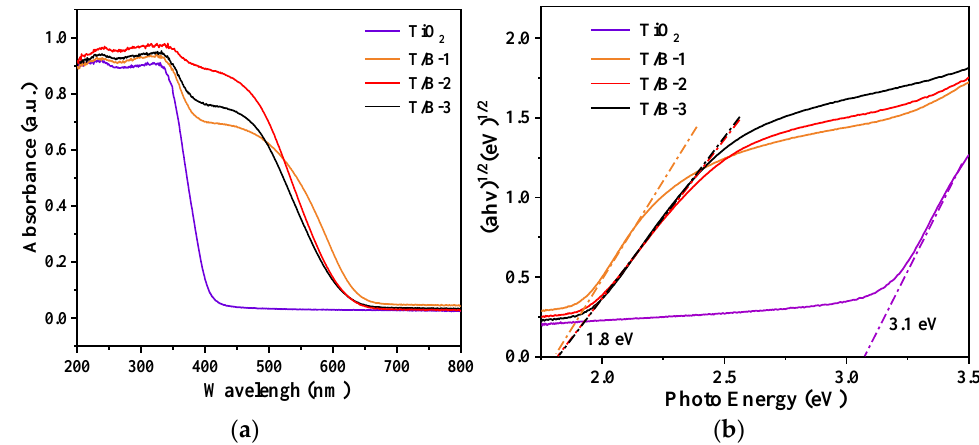
Figure 9. ( a ) UV–vis spectra of composite fibers prepared from hydrothermal solutions with different components, ( b ) bandgap diagram of composite fibers prepared by hydrothermal solution with different composition.